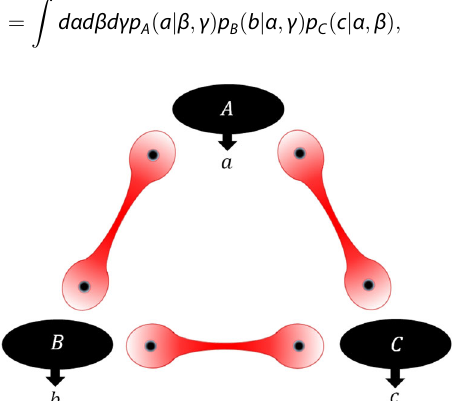
Fig. 3 Triangle network. Three nodes pairwise share pairs of entangled qubits and each perform the Elegant Joint Measurement on their respective qubit